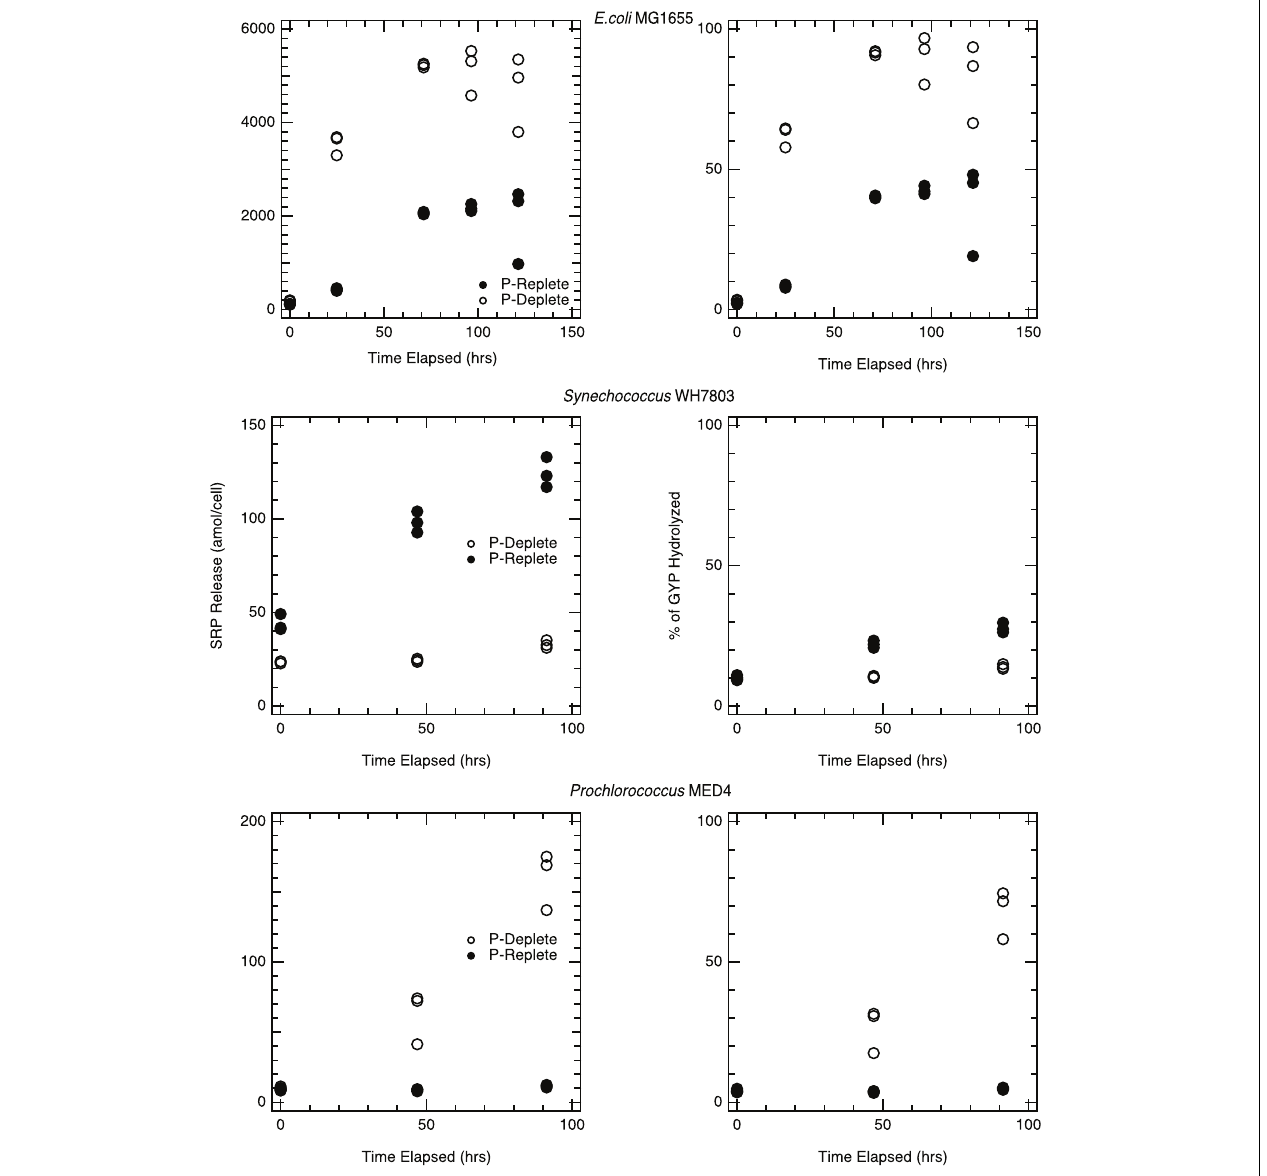
FIGURE 5 | Hydrolysis of GYP during incubations with pure culture lysate: Figures represent pure culture lysates, E. coli K-12 MG1655 (top), Synechococcus WH7803 (middle) and Prochlorococcus MED4 (bottom) in which the lysate was spiked to a 1mM initial glycerophosphate concentration and was monitored for at least 96hrs. For each time point, triplicate lysate incubations were measured, and the analytical error bars for each measurement are within the size of the symbols. Each phosphorus treatment is statistically significant for the strains above; p < 0.01.